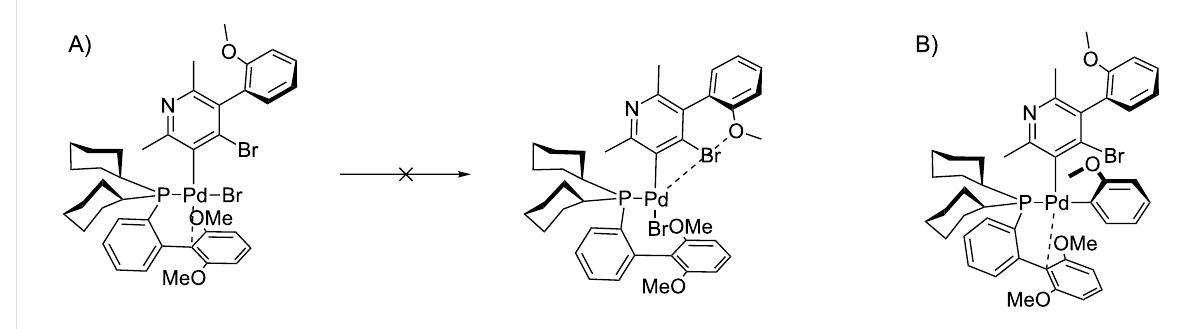
Figure 8: Proposed intermediates for the 1,3-addition with methoxy group. A) Oxidative addition step. B) Transmetalation step.